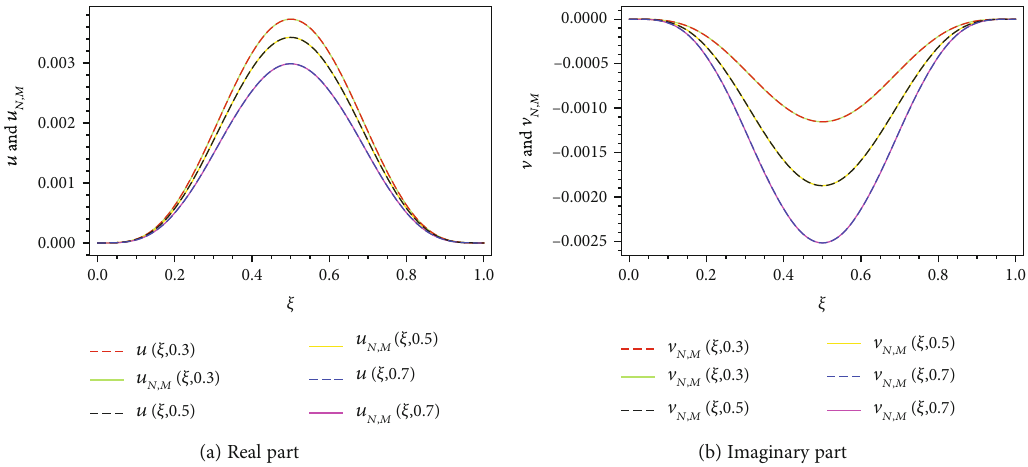
Figure 6: ξ -direction curves for the approximate and exact solutions of real and imaginary parts of Equation (35).